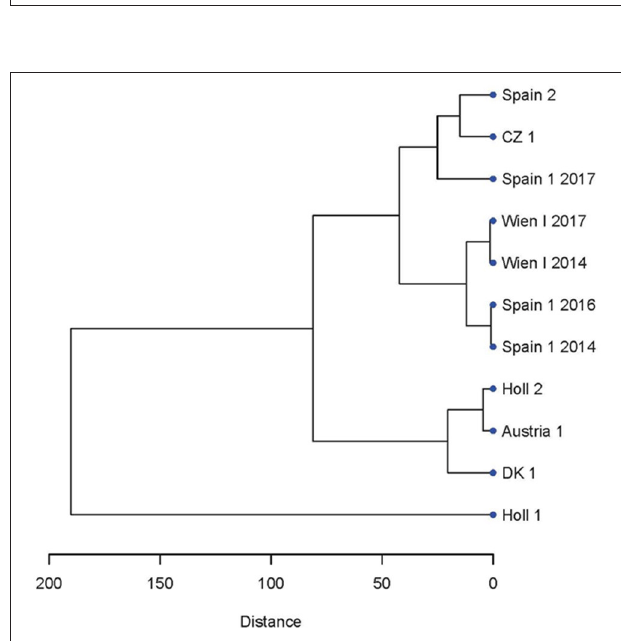
FIGURE 3 | Dendrogram showing the relatedness of the strains and isolate of C. suis based on the microsatellite PCR fragments lengths evaluated by CE (see Figure 1